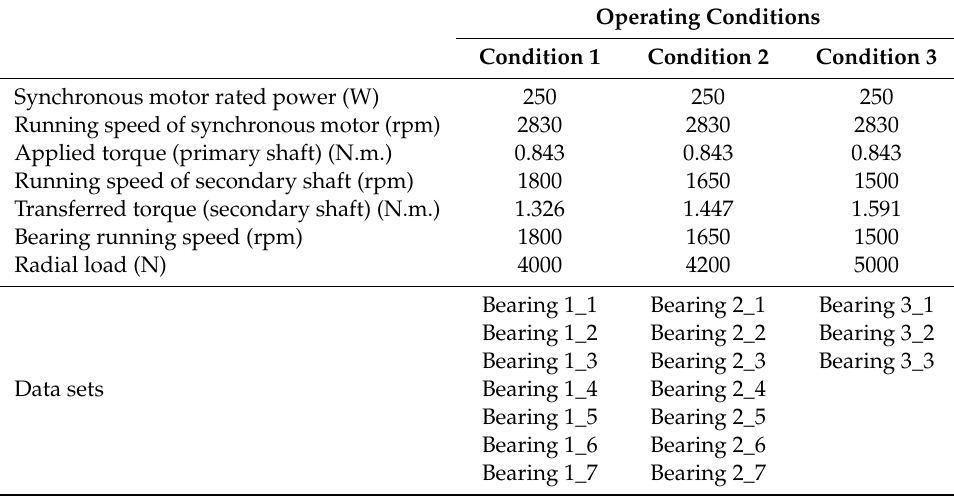
Table 2. Operating conditions of the di ff erent data